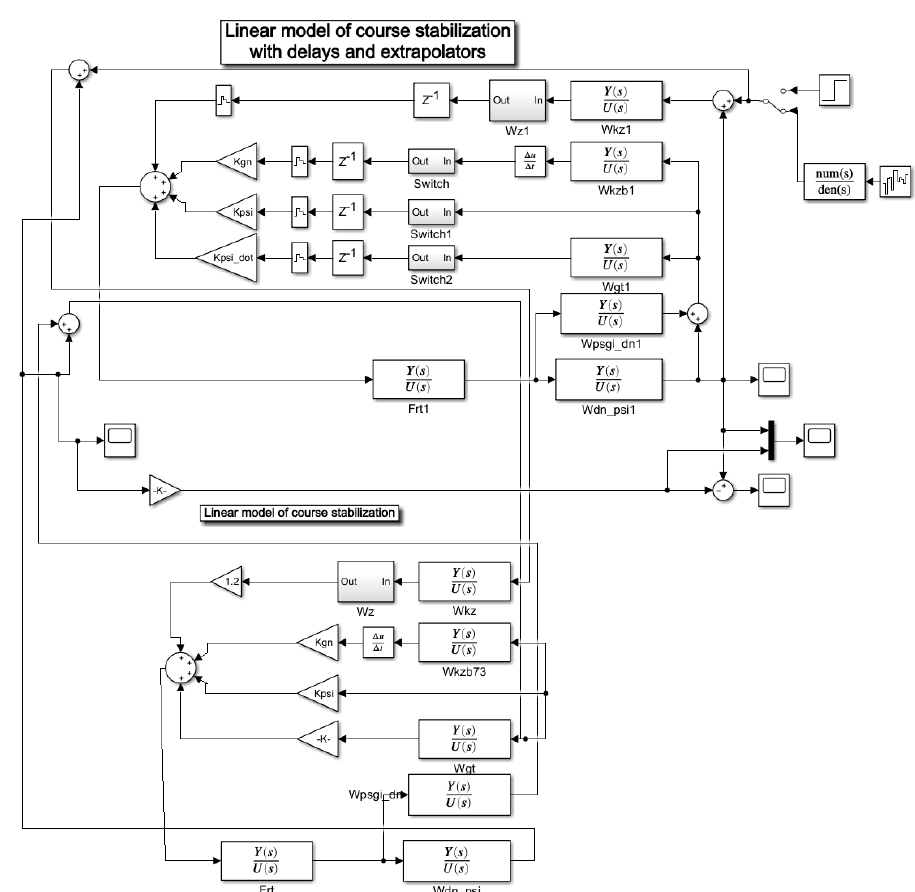
Figure 9. Simulink—diagram of a continuous and multiloop continuous–discrete UAV course stabilization system.